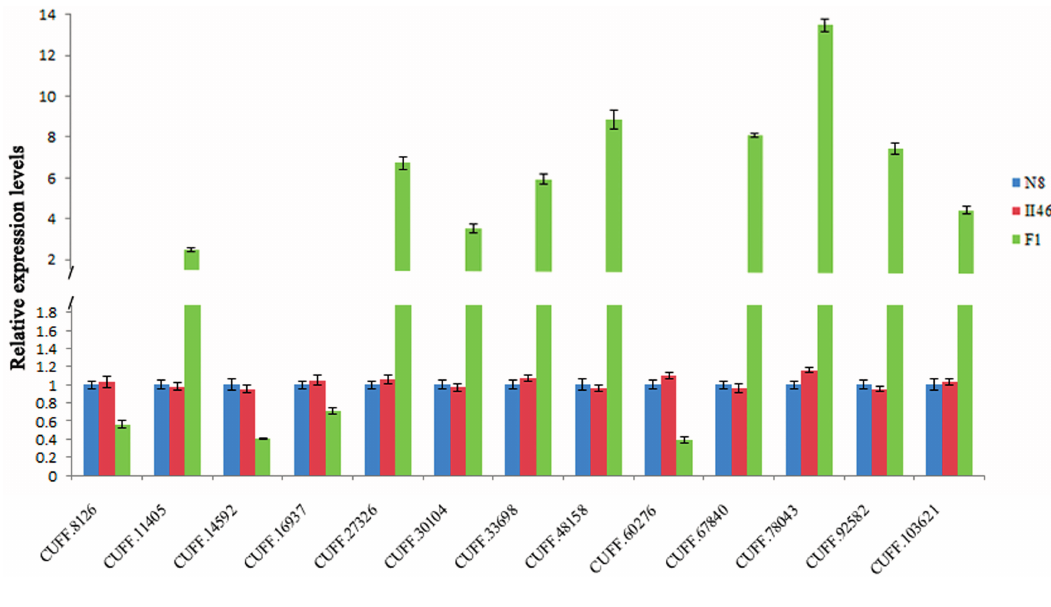
Figure 5. Genes with expression levels validated by qRT-PCR. CUFF.8126: Abscisic stress-ripening protein 2, CUFF.11405: vernalization insensitive 3, CUFF.14592: Defensin-like protein, CUFF.16937: Programmed cell death protein 4, CUFF.27326: senescence-associated-like protein, CUFF.30104: E3 ubiquitin ligase BIG BROTHER-related protein, CUFF.33698: Minor histocompatibilityantigen H13-like, CUFF.48158: BONZAI 3-like, CUFF.60276: auxin transport protein BIG-like, CUFF.67840: Autoimmune regulator, histone H3 acetyltransferaseIDM1, CUFF.78043: Ubiquitin carboxyl-terminal hydrolase 25, CUFF.92582: Histone acetyltransferase HAC5, CUFF.103621: TIFY 10A-like. Bars show standard